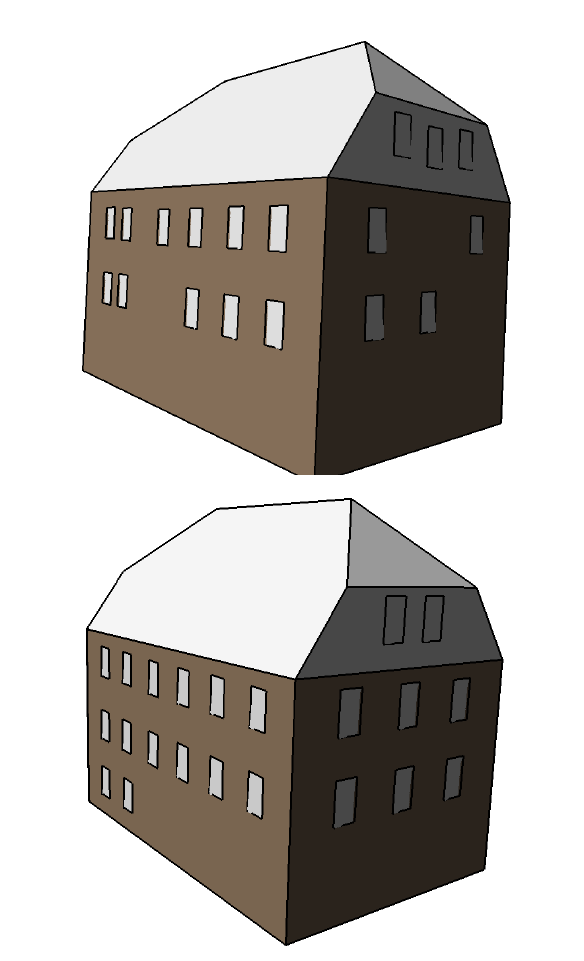
Figure 6. LOD 3 model with extracted